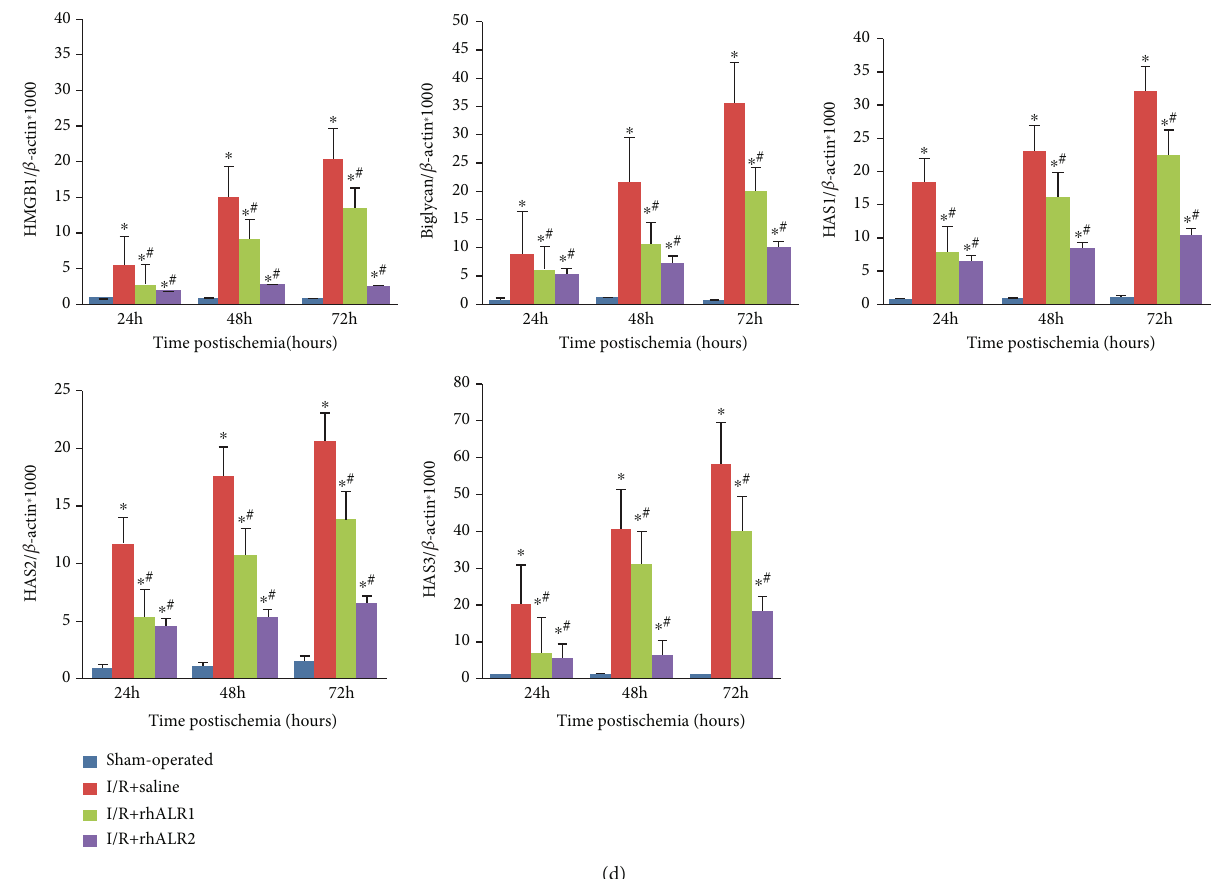
Figure 6: rhALR downregulated the expression of TLR4 and endogenous ligands after I/R injury. (a, b) TLR4 mRNA expression after renal I/R injury was measured by immunohistochemical (magni fi cation, × 200) and real-time PCR methods, respectively. TLR4 expression was increased markedly in kidneys after rat I/R injury. Intraperitoneal injection of rhALR markedly decreased the expression of TLR4 vs. I/R +saline. TLR4 protein expression in untreated control cells was low. (c) The endogenous ligand mRNA expression began to increase since 24 h and reached the peak at 72 h following I/R injury. Expression of these mRNA downregulation in I/R+rhALR1 and I/R +rhALR2 at the same points. All data were shown as the mean ± SD . ∗ P < 0 : 05 vs. sham, # P < 0 : 05 vs.